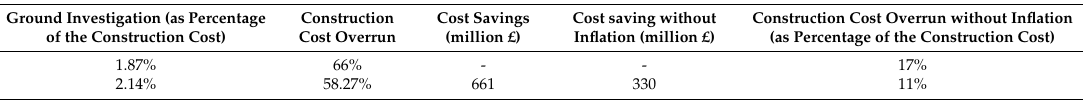
Table 14. Construction Cost overrun and cost savings with and without inflation with two di ff erent levels of GI for the Channel